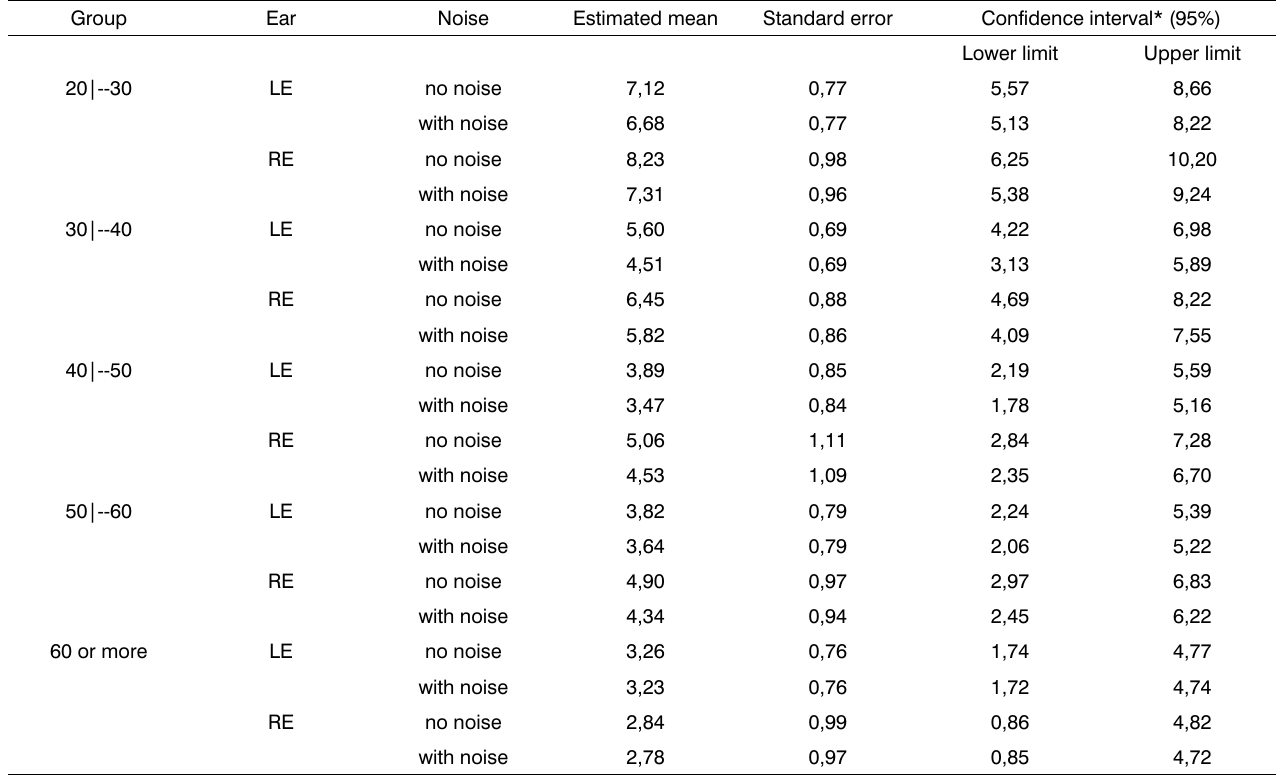
Table 1. Estimated mean confidence intervals, standard error and confidence interval.